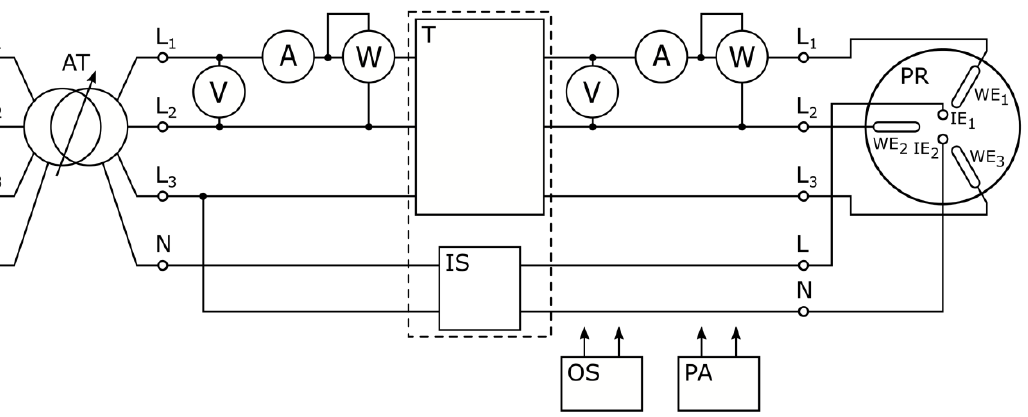
Figure 6. Measuring system for testing the cooperation of a plasma reactor with different types of power supplies, AT—autotransformer, V—voltmeter, A—ammeter, W—wattmeter, OS—oscilloscope, PA—power analyser, PR—plasma reactor, T–reactor working electrodes power circuit, IS—ignition electrodes power